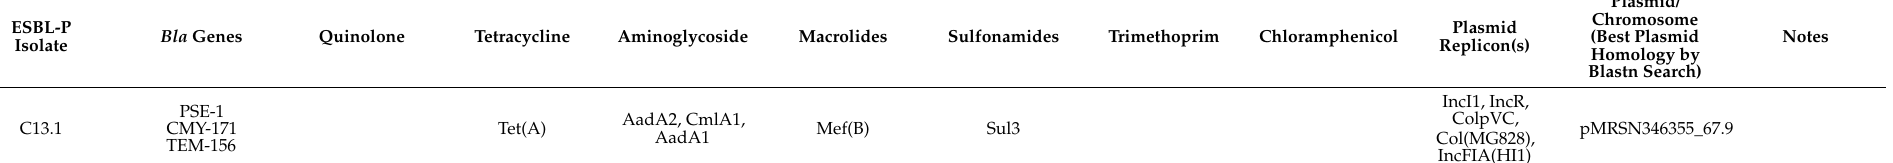
Table 2. The resistome of the ESBL-PE isolates colonizing healthy community dogs, predicted by NDARO and the β -Lactamase Data base (BLDB). Plasmid replicons were detected by the MobileElementFinder web